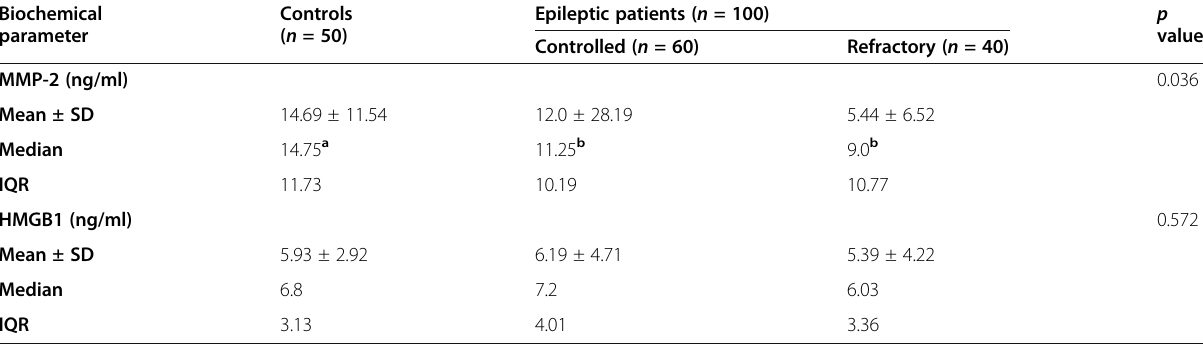
Table 3 Serum MMP-2 and HMGB1 in patients with refractory epilepsy and controls Biochemical